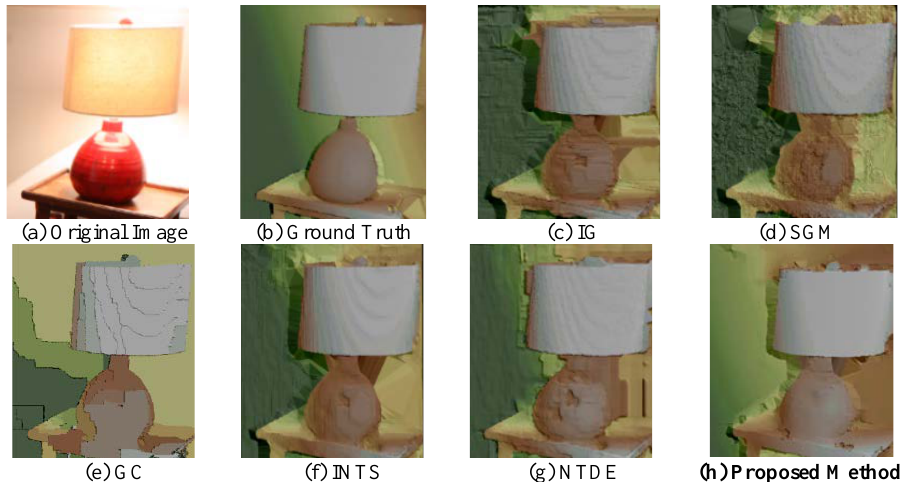
Figure 1. Results of Different Matching Methods in Slanted